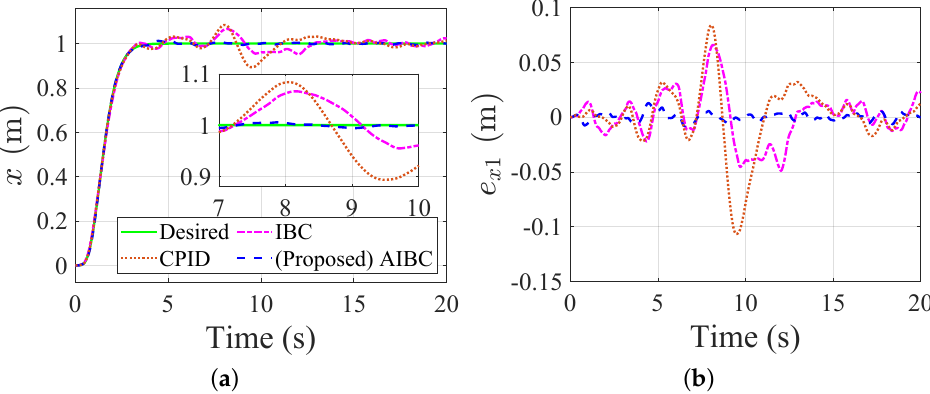
Figure 5. Comparison of the desired command and system response in the x -direction for different approaches. ( a ) desired command and actual states; ( b ) tracking errors.